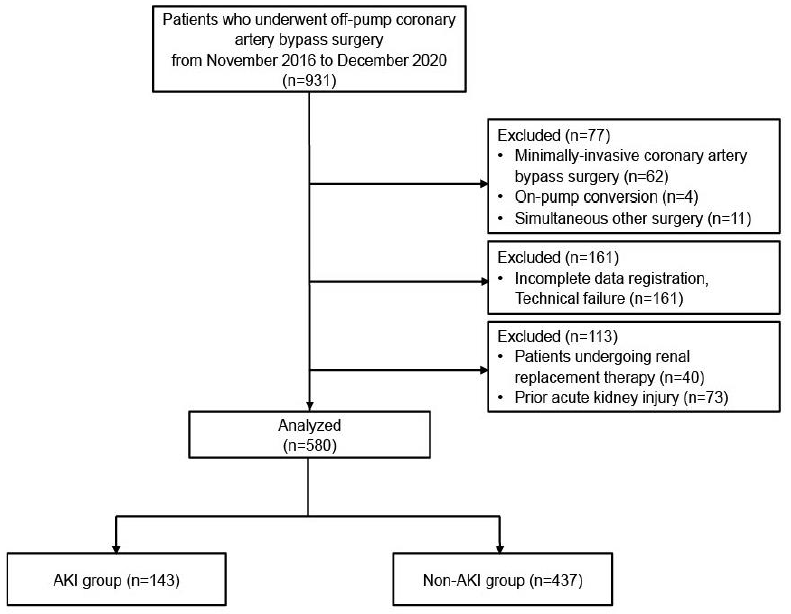
Figure 1. Flow diagram of the study.